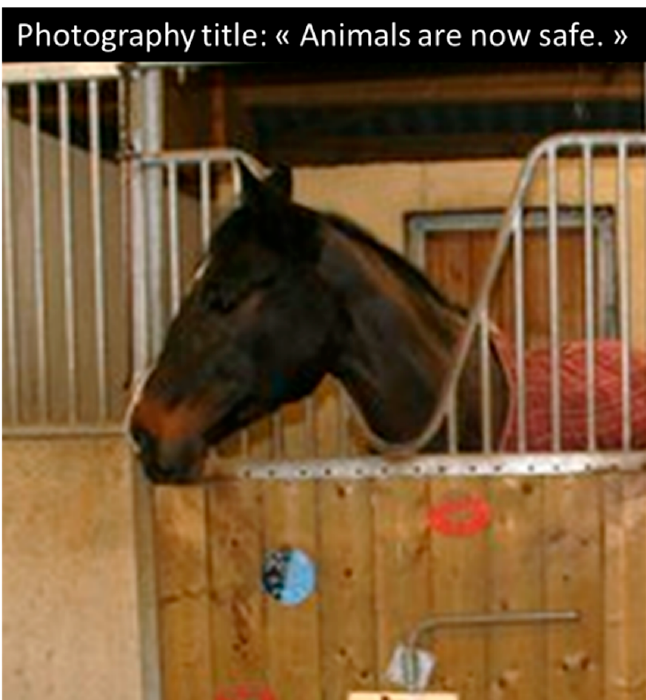
Figure 1. Example of popular fact reported in the French press (Sud-Ouest published on the 4 Feb- ruary 2020): it is said that a group of horses living out in pasture have been fortunately saved and now placed in “security” in stalls. © Photo credit: Martine Hausberger. See also